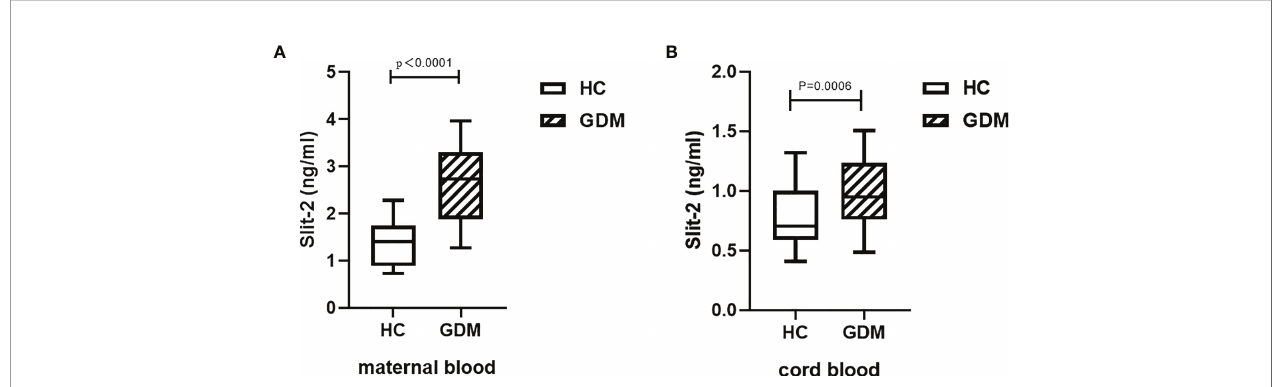
FIGURE 1 | Slit-2 levels in maternal peripheral blood and neonatal cord blood of GDM patients and HC. (A) Comparison of Slit-2 levels in maternal peripheral blood between the GDM patients and the HC. (B) Comparison of neonatal cord blood Slit-2 levels between the GDM patients and the HC. Slit-2, Slit guidance ligand 2; HC, Healthy Control; GDM, gestational diabetes mellitus.